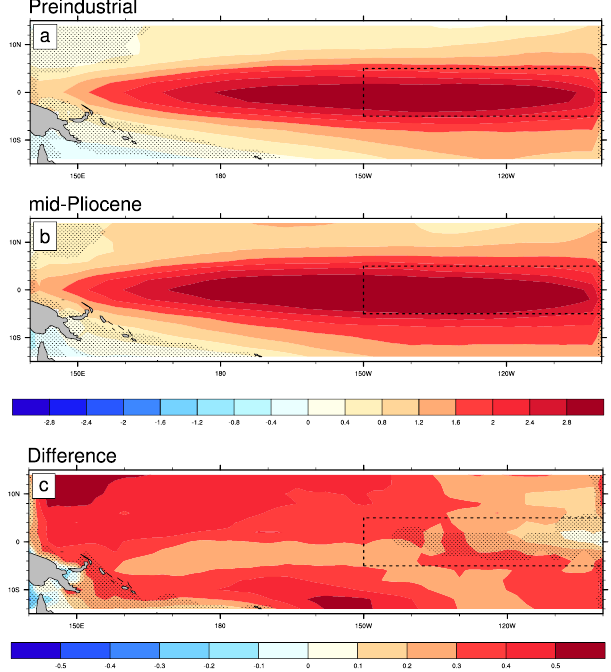
Figure 3. The ensemble average empirical orthogonal functions computed for the tropical Pacific. All patterns are defined to be pos- itive in the Niño 3.4 region (dotted line). Stippling indicates that less than eight of the nine models agree on the sign of the change. The change in standard deviation is defined as Pliocene minus preindus-